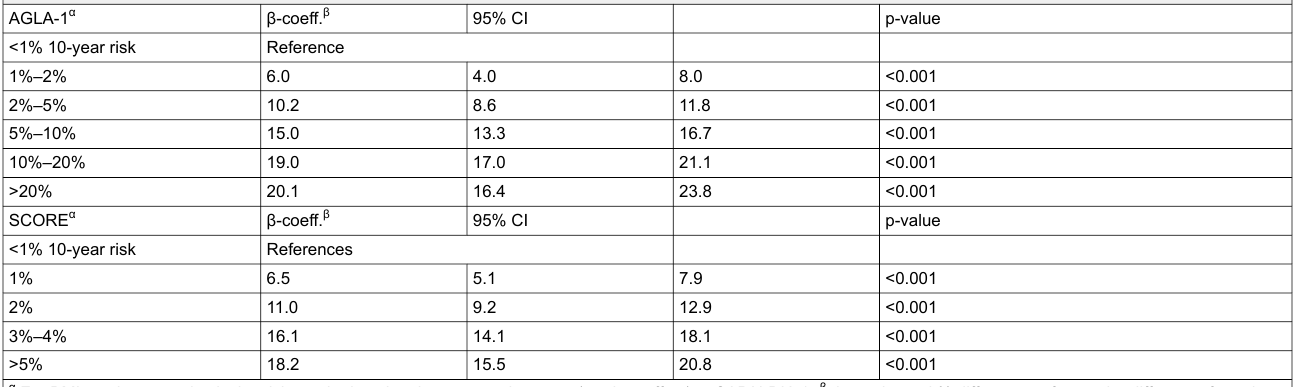
Supplemental table 3 : Association between AGLA-1 and SCORE and aCIMT, adjusted for BMI, pack years, physical activity and educational status at SAPALDIA 2. AGLA-1 α